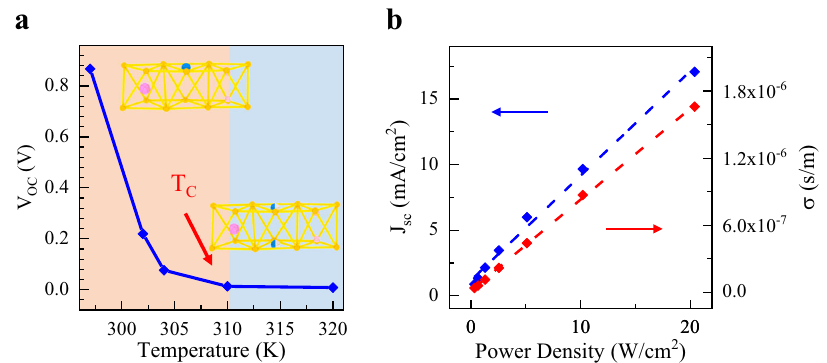
Fig. 3 Temperature and power dependence of the BPVE in CIPS. a The open-circuit voltage as a function of the temperature. The V oc vanishes when the temperature increases to the phase transition temperature at about 315 K. Insets display the crystal structures of CIPS in ferroelectric and paraelectric phases. b The short-circuit current density (left axis) and the photoconductivity (right axis) as a function of the illumination laser power density. Linear dependence of the J sc and σ pv on excitation power is in accord with Eq. (2).